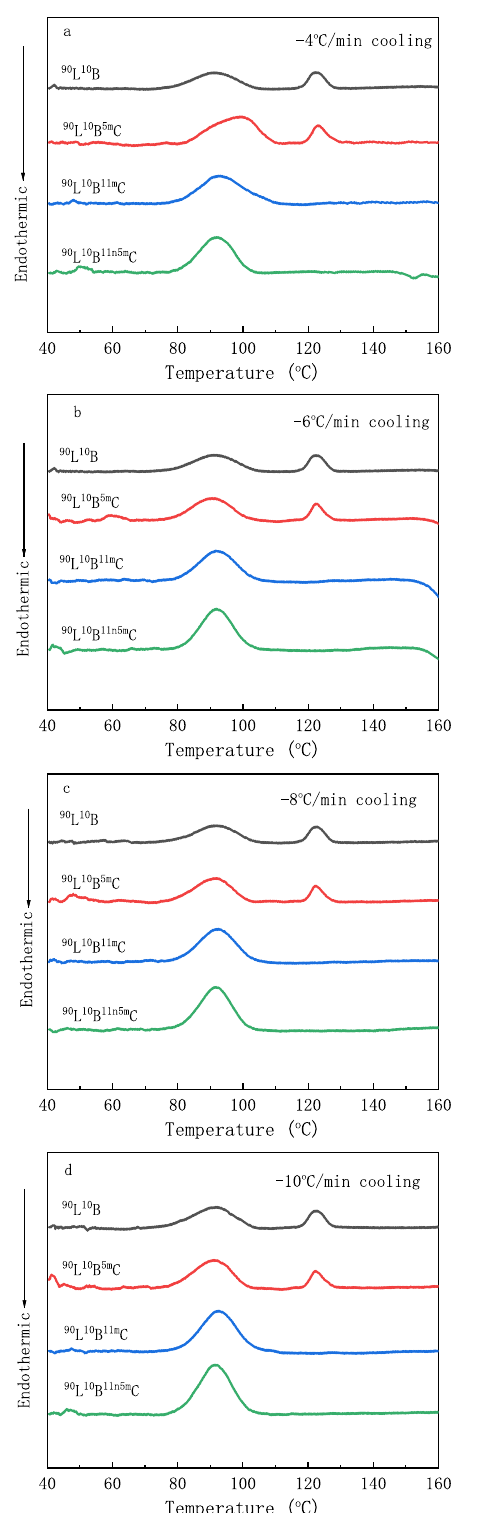
Figure 2: DSC thermograms of PLA/PBAT blend and PLA/PBAT/ CaCO 3 composites for cooling at the scan rate of ( a ) − 4°C · min − 1 , ( b ) − 6°C · min − 1 , ( c ) − 8°C · min − 1 , and ( d ) − 10°C · min − 1 .